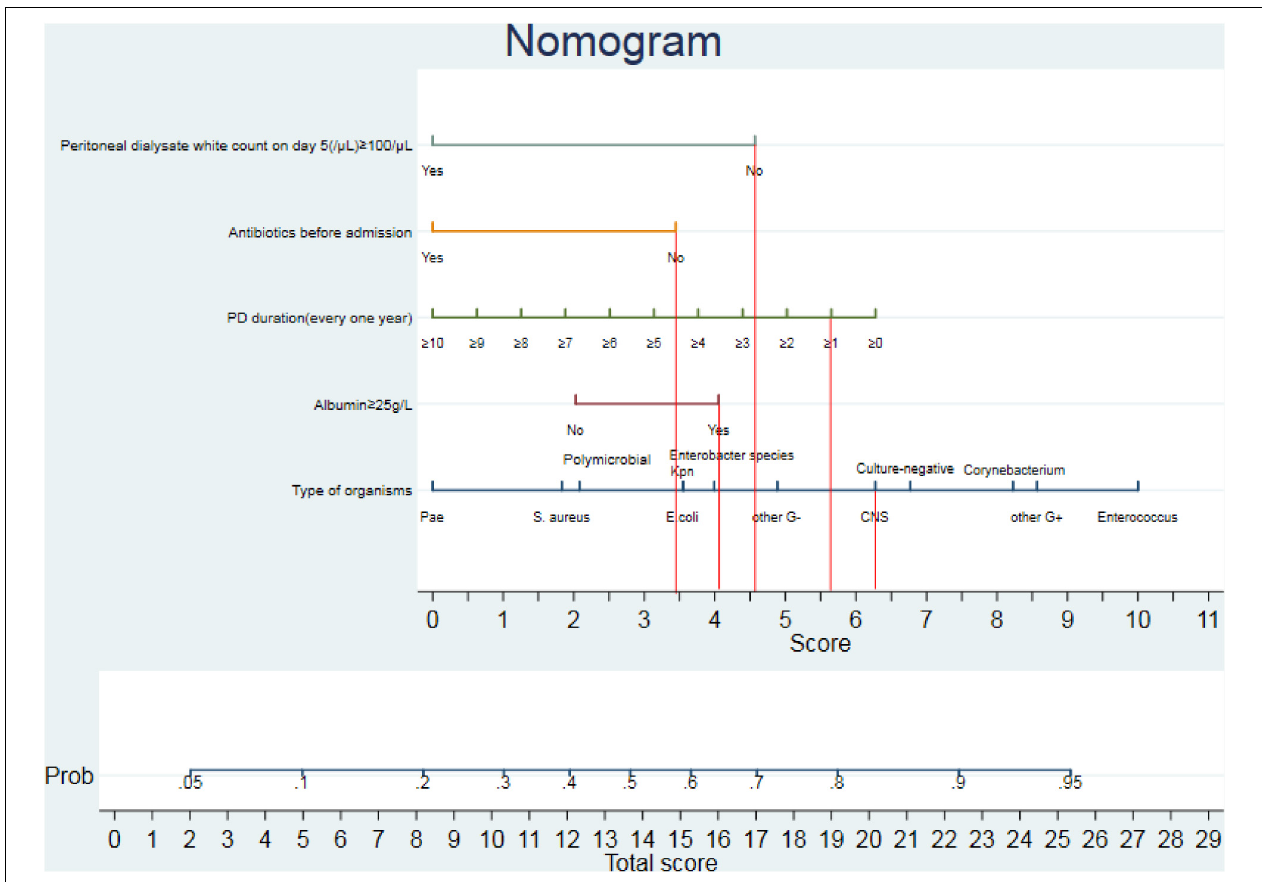
FIGURE 2 | Nomogram for predicting the peritonitis-related catheter removal of peritoneal dialysis (PD)-associated peritonitis (PDAP). The nomogram provided a method to calculate the probability of peritonitis cure in patients with PDAP based on the combination of covariates in each patient. Its usage was illustrated with a 1-year history of PD, no antibiotics prior to admission, a serum albumin of 40 g/L, peritoneal dialysate white cell count on day 5 (/ µ l) < 100/ µ l, and CNS of causative organisms (vertical lines). The scores for PD duration, no antibiotics prior to admission, serum albumin, peritoneal dialysate white cell count on day 5 (/ µ l) < 100/ µ l, and bacterial infection for this patient were 5.7, 3.4, 4.1, 4.6, and 6.3 points, respectively, resulting in the total score of 24.1, which represented approximately 0.93 of cure probability. Pae, Pseudomonas aeruginosa ; S. aureus , Staphylococcus ; Kpn, Klebsiella pneumoniae ; E. coli , Escherichia coli ; CNS, coagulase-negative Staphylococcus .